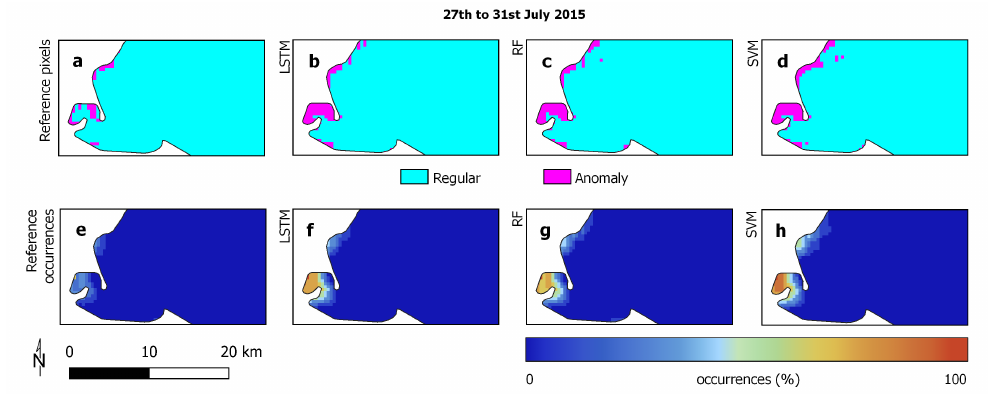
Figure 13. Period trend forecasting based on pixels ( a – d ) and occurrences ( e – h ) from 27–31 July 2015, related to Lake Erie. Plots ( a , b ) represent the mapping of the reference data.